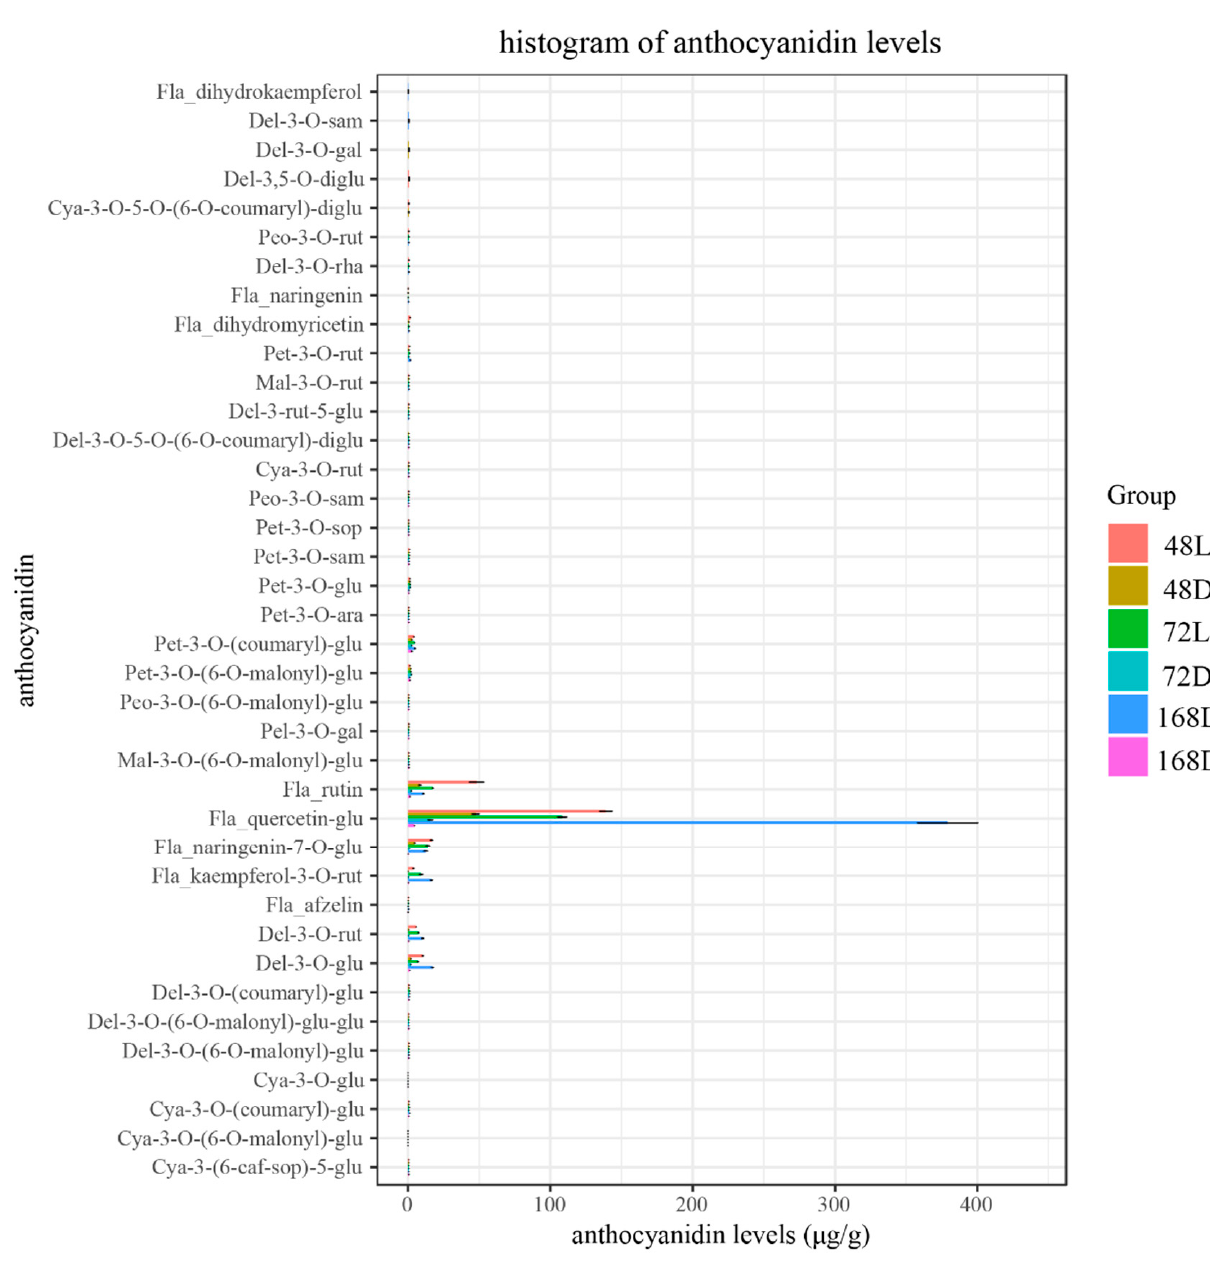
Figure 3. Histogram of the flavonoid type and content in each sample. The abscissa is content. The ordinate is the type. The picture shows the average value of three biological repetitions. The error bars indicate the standard errors.